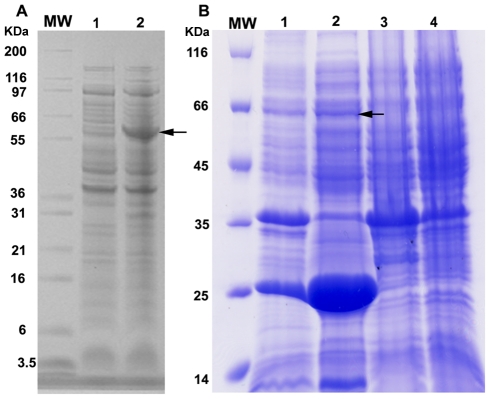
Electrophoretic patterns of expression products of recombinant SjTGR.(A) Expression products from E. coli BL21 transformed with recombinant SjTGR-pET41a and induced with 1 mmole/L of IPTG at 37°C for 4 h. Lane 1: Supernatant of bacterial lysate. Lane 2: Precipitate of bacteria lysate resuspended with PBS. The black arrow indicates the expressed SjTGR protein band. MW: Protein molecular weight marker. (B) Expression products from transformed or non-transformed E. coli BL21 induced with 0.5 mmole/L of IPTG at 24°C for 24 h. Products in precipitates (lane 1) or supernatant (lane 2) of induced bacteria containing plasmid SjTGR-pET41a show expression of the recombinant SjTGR (black arrow). Expression products of induced bacteria containing plasmid pET41a (lane 3) or of induced non-transformed bacteria (lane 4) are also shown. MW: Protein molecular weight marker.